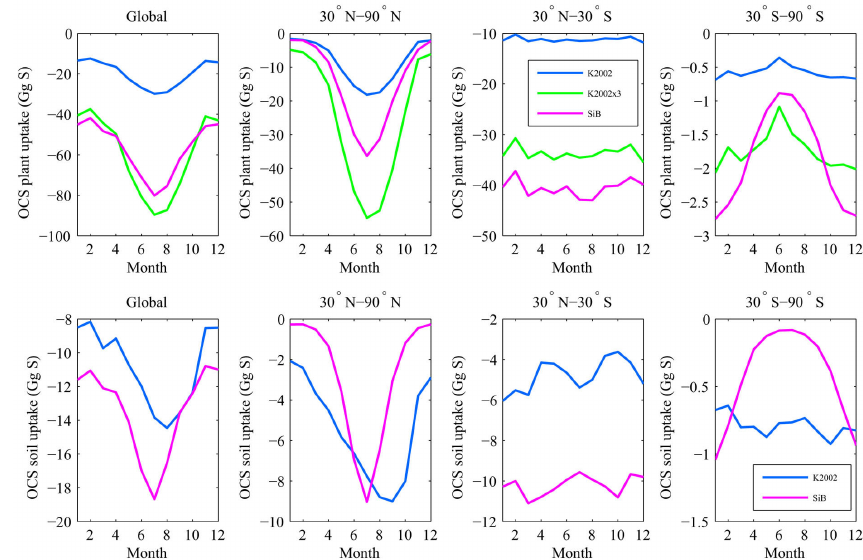
Figure 5. Monthly totals of OCS plant uptake (top) and soil uptake (bottom) of K2002 (blue), K2002x3 (green), and SiB (magenta) for global, 30–90 ◦ N, 30 ◦ N–30 ◦ S, and 30–90 ◦